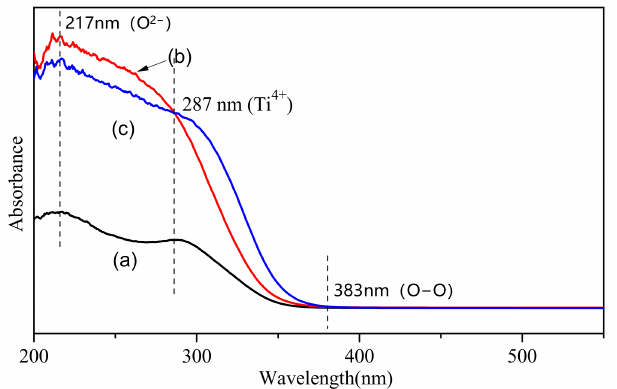
Figure 5. UV-vis spectra of NT-purchased ( a ), NT-P25 ( b ), and NT-TBOT ( c ), after treatment with hydrogen peroxide.